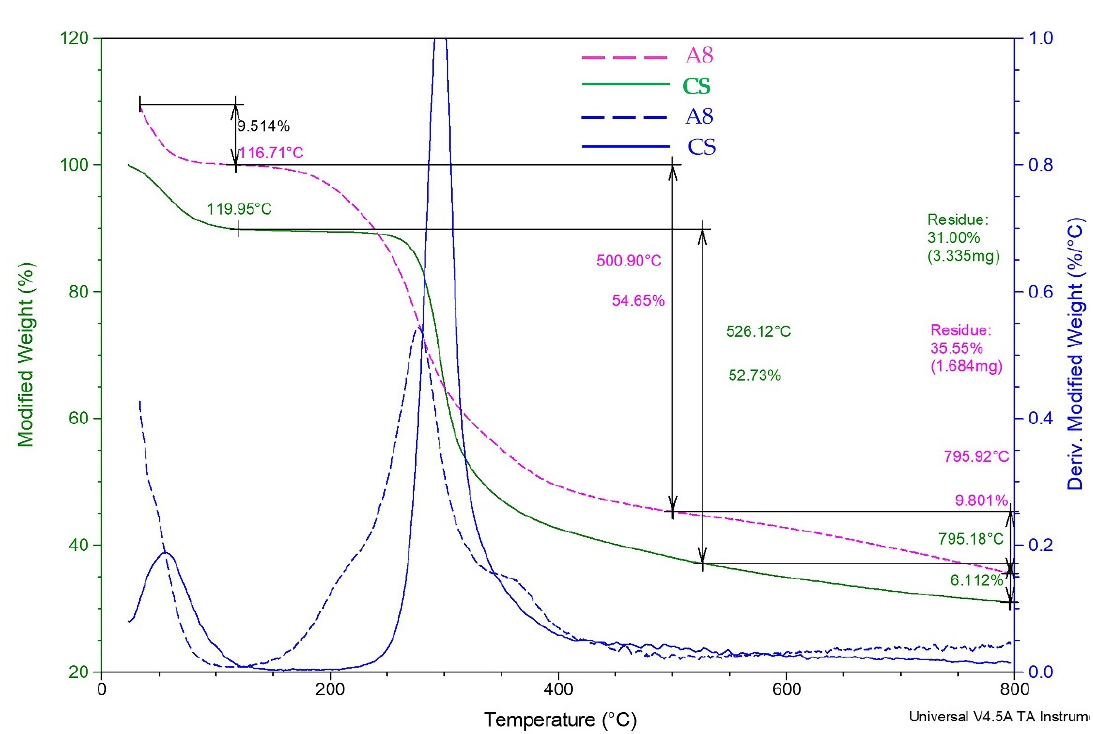
Figure 4. TGA analysis of chitosan (CS) and chitosan particulate hydrogels (A8 sample).